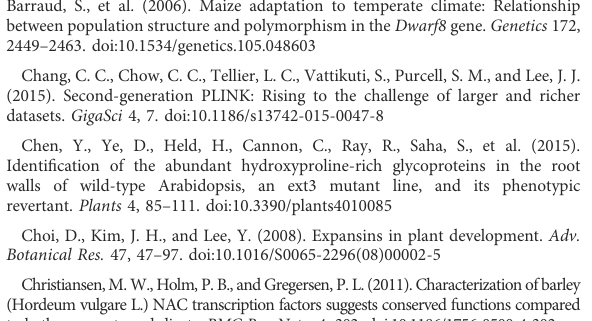
SUPPLEMENTARY FIGURE S1 Brace root angle and brace root diameter normal distribution analysis., (A) , BRA, (B) , BRD. SUPPLEMENTARY FIGURE S2 Q-Q plots ofBRA andBRDbyMLM. Q-Qplots for BRA-BLUP, 16LN-BRA, 16JL-BRA, 17LN-BRA, BRD-BLUP, 16LN-BRD, 16JL-BRD and 17LN-BRD are shown in (A) , (B) , (C) , (D) , (E) , (F) , (G) and (H) , respectively. SUPPLEMENTARY FIGURE S3 Manhattan plots of BRA and BRD by BLINK. Manhattan plots for BRA- BLUP, 16LN-BRA, 16JL-BRA, 17LN-BRA, BRD-BLUP, 16LN-BRD, 16JL- BRD and 17LN-BRD are shown in (A) , (B) , (C) , (D) , (E) , (F) , (G) and (H) , respectively. The black lines show genome-wide signi fi cance at stringent thresholds of 1.84 × 10 − 6 . SUPPLEMENTARY FIGURE S4 Q-Q plots of BRA and BRD by BLINK. Q-Q plots for BRA-BLUP, 16LN- BRA, 16JL-BRA, 17LN-BRA, BRD-BLUP, 16LN-BRD, 16JL-BRD and 17LN-BRDareshownin (A) , (B) , (C) , (D) , (E) , (F) , (G) and (H)